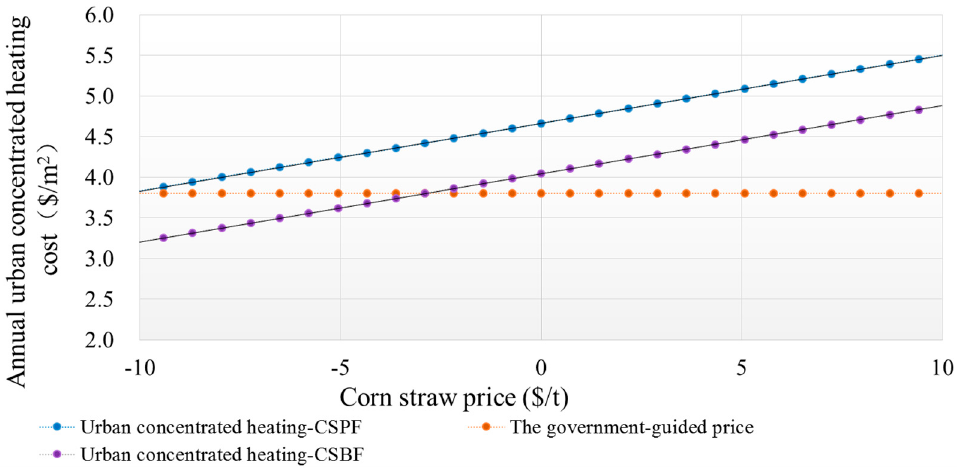
Figure 6. Influence of corn straw price on the economic performance of CSDF for urban concentrated heating.